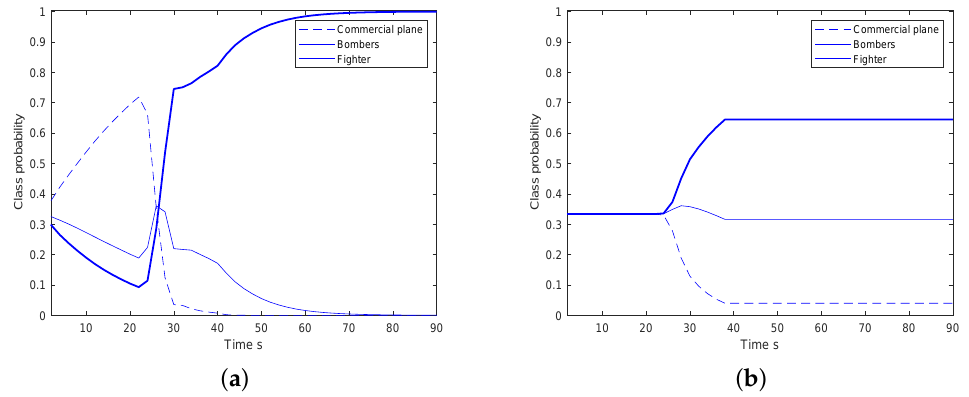
Figure 7. The comparison of the classification results of target 2; ( a ) Pignistic class probabilities of target 2 based on multiple models, ( b ) Pignistic class probabilities of target 2 based on single